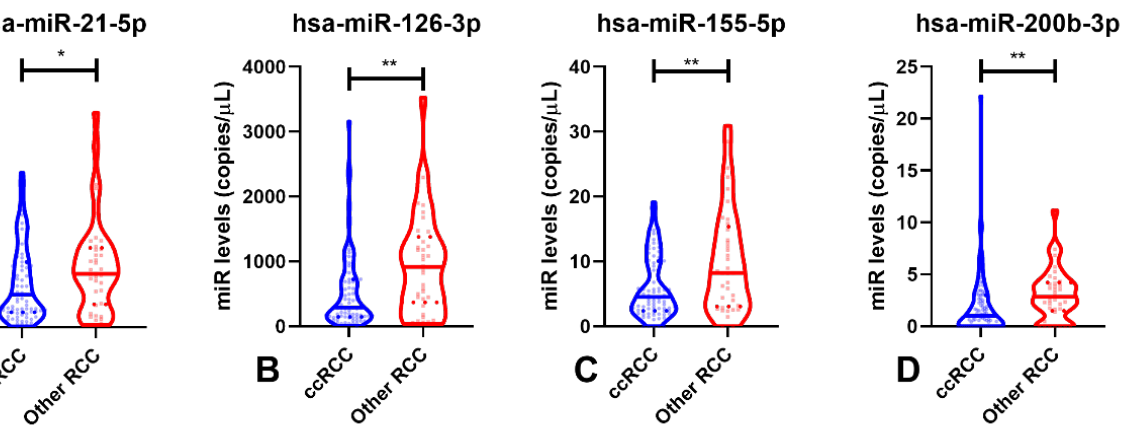
Figure 4. Violin plots of hsa-miR-21-5p ( A ), hsa-miR-126-3p ( B ), hsa-miR-155-5p ( C ) and hsa-miR- 200b-3p ( D ) levels in ccRCC and other RCCs (pRCC and chRCC). Dashed lines indicate the interquar- tile range and horizontal line the median of miR levels. Abbreviations: ccRCC—Clear-Cell Renal Cell